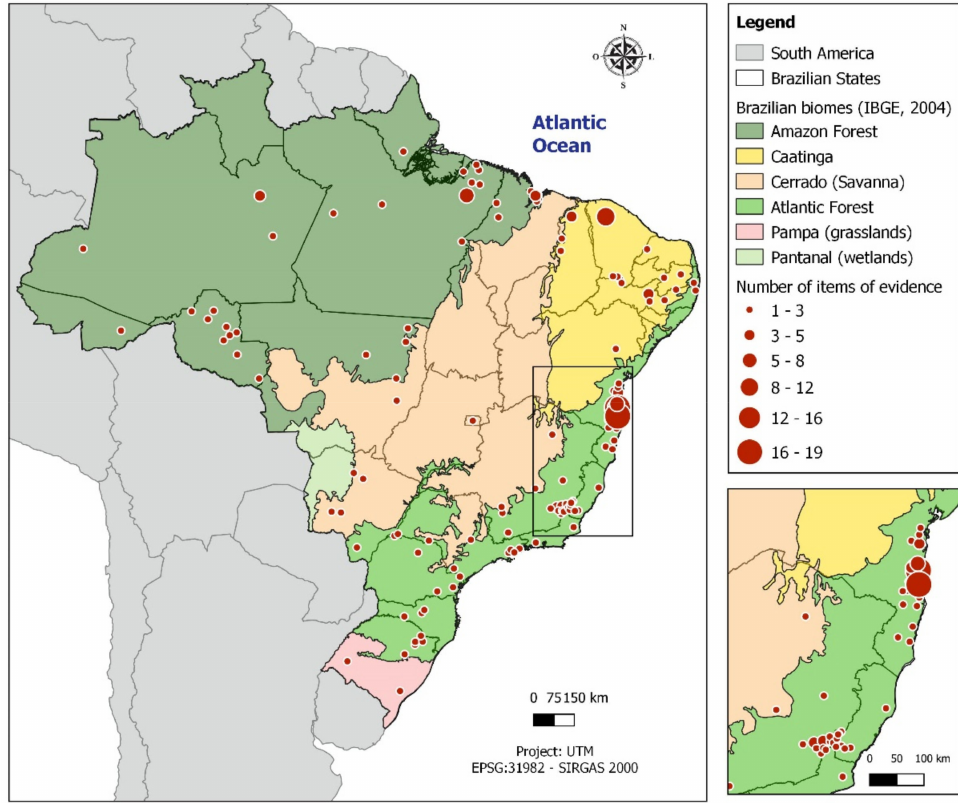
Figure 2. Map of Brazilian biomes and geographical distribution of the agroforestry sites studied in the 158 journal articles. Box on the right highlights the area with the highest concentration of studies assessed in Southeast Bahia